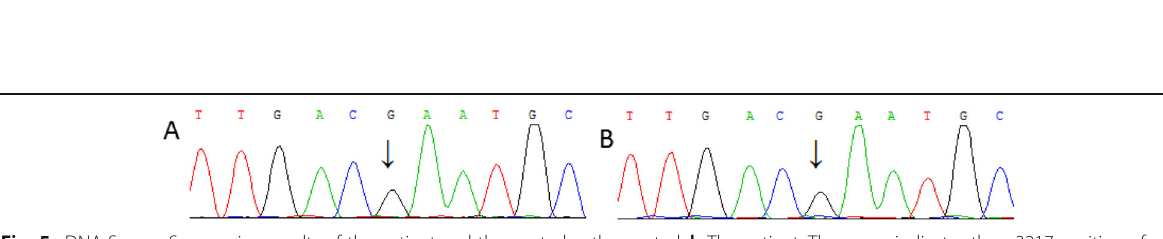
Fig. 4 MLPA testing results of the patient. a MLPA P065 Marfan Syndrome-1 probemix; b MLPA P066 Marfan Syndrome-2 probemix